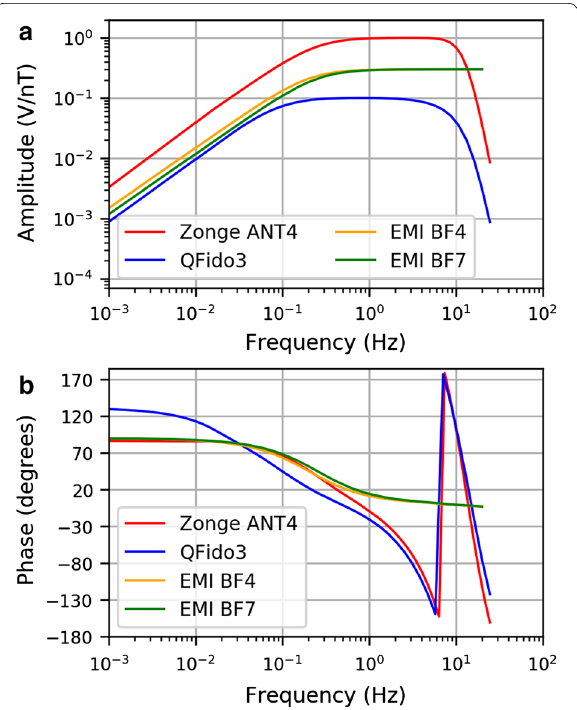
Fig. 4 a Amplitude spectra and b phase spectra of the response function of EMI BF4, EMI BF7, Zonge ANT4, and QFido3 coils. Phase shifts are plotted between 180° and 180°. The QuakeFinder system − low-pass filters manifest as “phase wrapping” near 10 Hz in b